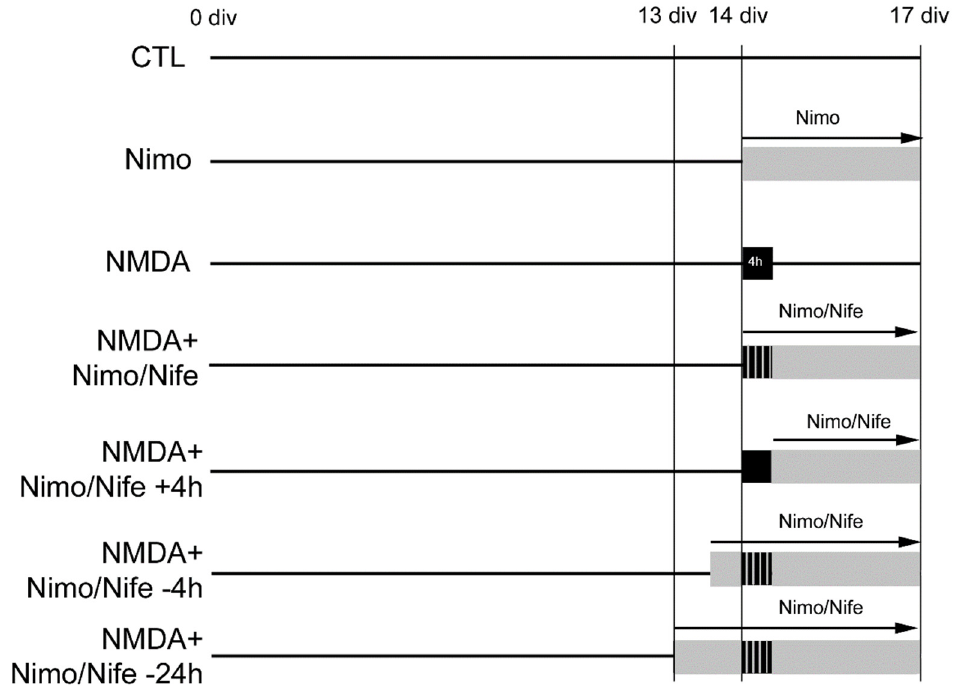
Figure 5. Treatment of murine OHSC. Murine OHSC were excitotoxically lesioned on 14 div. Next to the negative control (CTL) and positive control group damaged with NMDA (10 µ M) for 4 h, one set of OHSC was treated simultaneously with NMDA (10 µ M) and nimodipine (Nimo) or nifedipine (Nife). Further groups of OHSC were pretreated with nimodipine or nifedipine for 4 or 24 h before lesion.